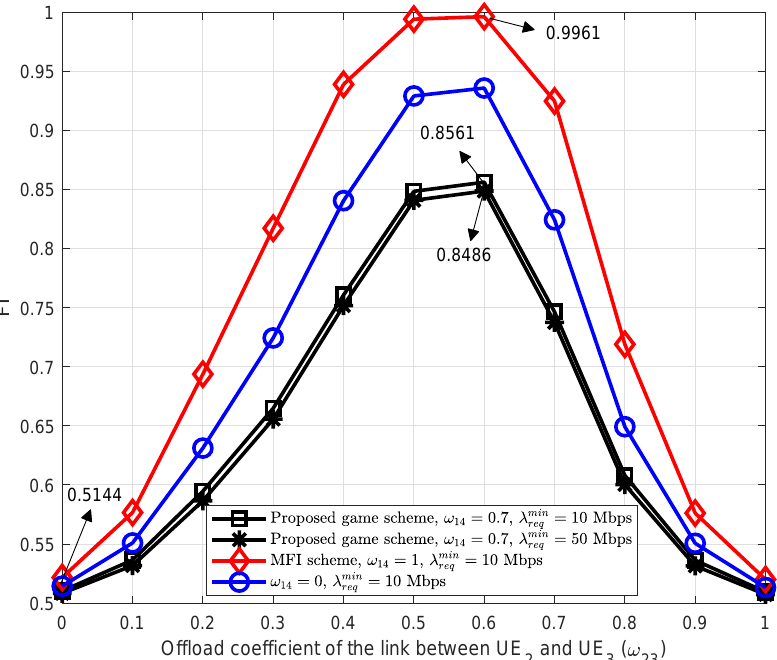
Figure 6. The FI value according to offload coefficient pairs of the link between UE 2 –UE 3 ( ω 23 ) and the link UE 1 –UE 4 ( ω 14 ) when the minimum required data rate is 10 Mbps and 50 Mbps, respectively, and e hv mean = 15